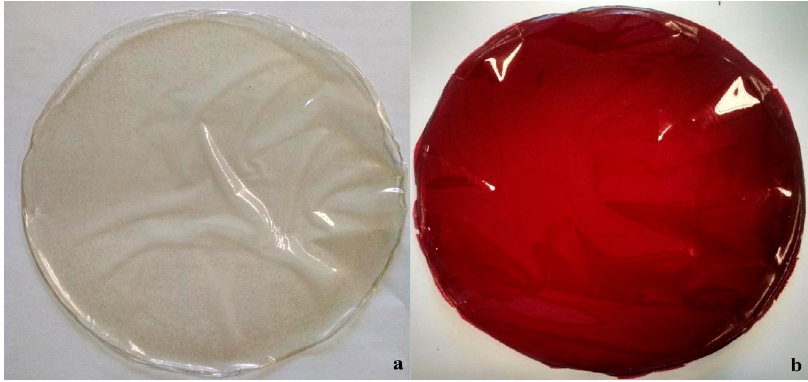
Figure 4. Biodegradable carrageenan films appearance: ( a ) CAR-control and ( b ) CAR-JPE.